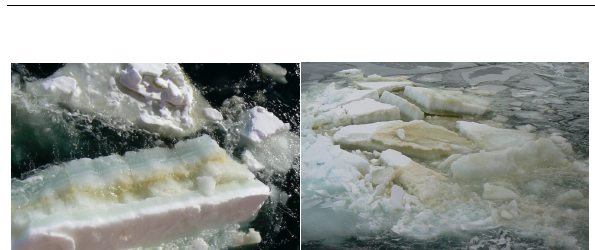
Fig. 1. Cruise path of ES033 in the Southern Ocean and Weddell Sea, and ice cover on 21 February 2011. Ice cores were collected between 5 and 13 February. Between 19 and 22 February the ice shelf experiment was set up close to Halley, where the ship was moored.